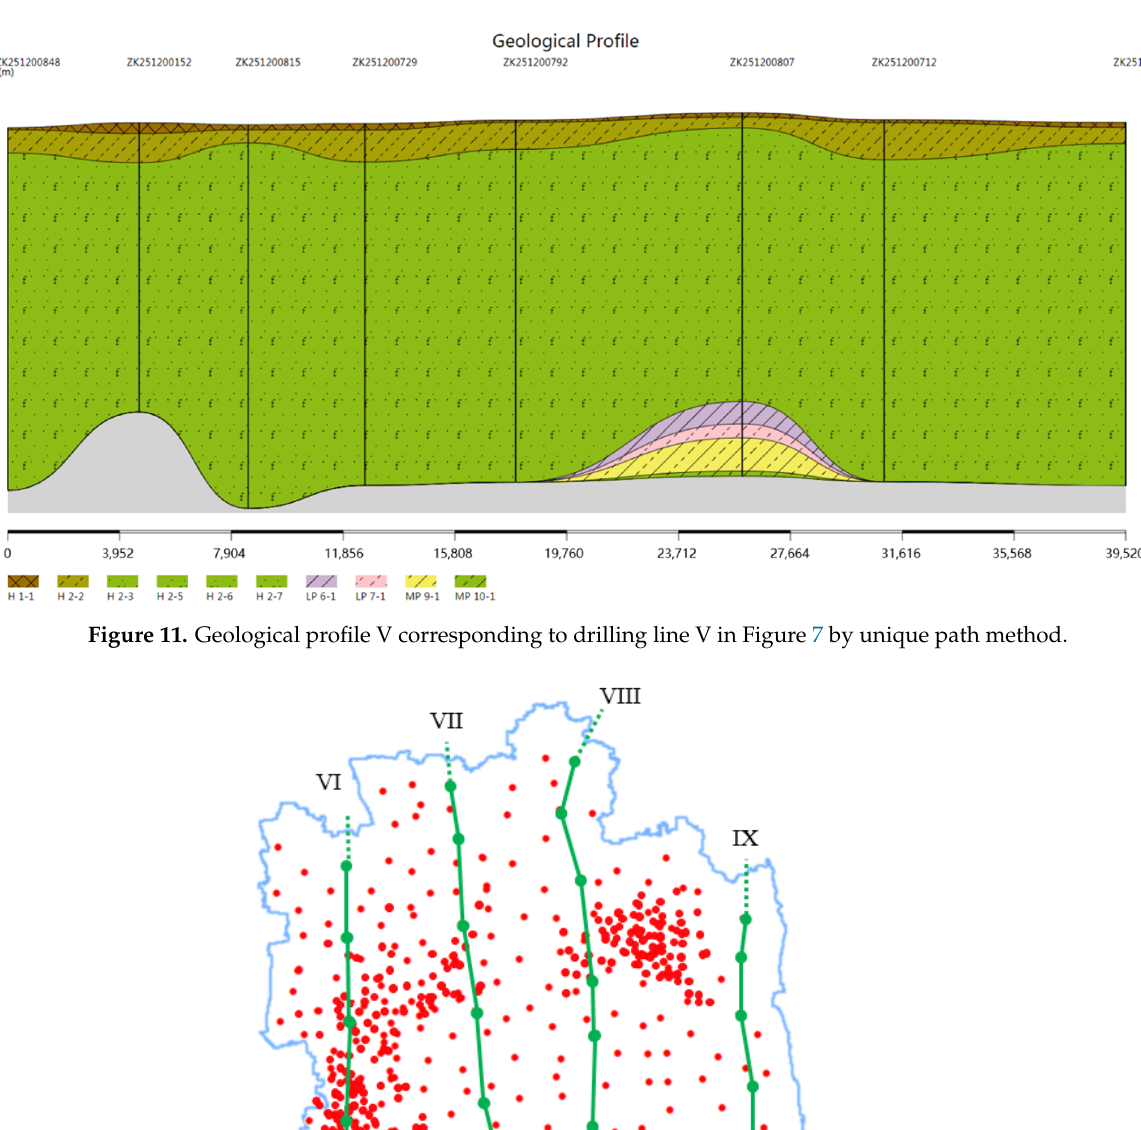
Figure 11. Geological profile V corresponding to drilling line V in Figure 7 by unique path method.